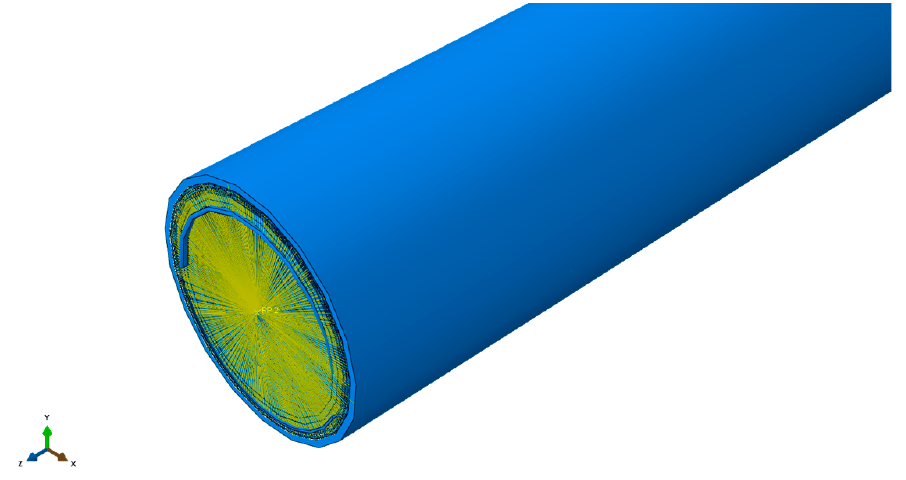
Figure 5. The sectional view of a multi-storey structure.